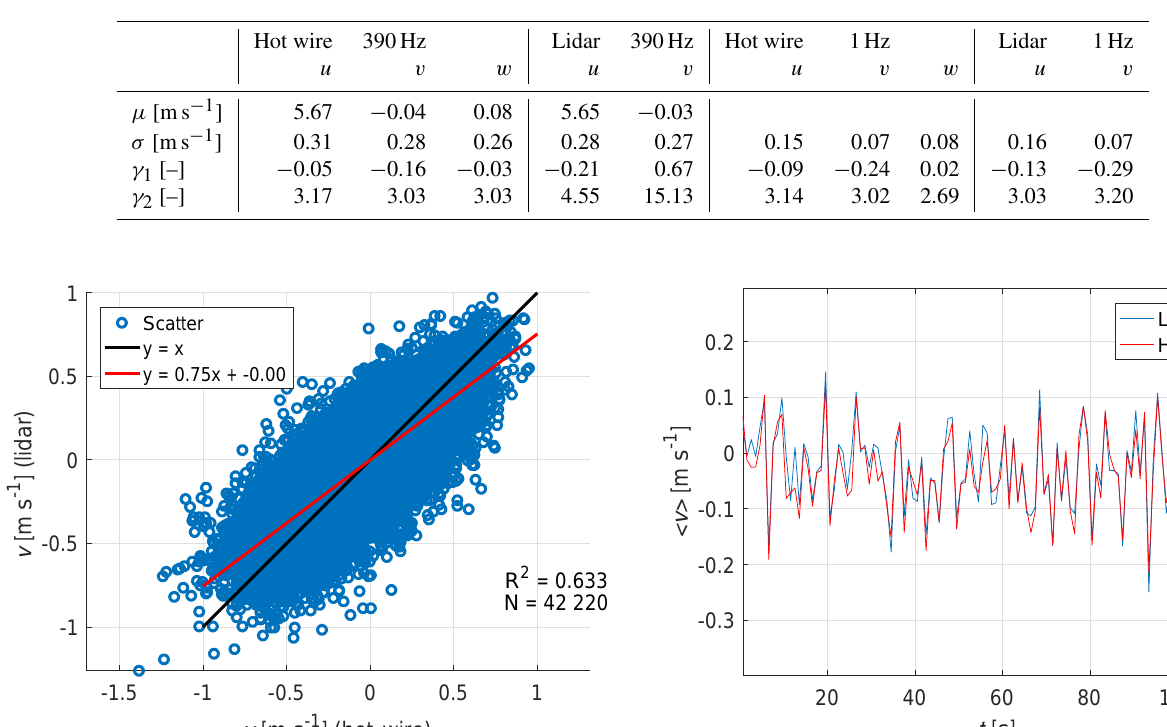
Table 1. Comparison of the statistics for the 390 and 1Hz wind speed components measured at a point over a 2min time frame by the hot-wire probe and the lidars.